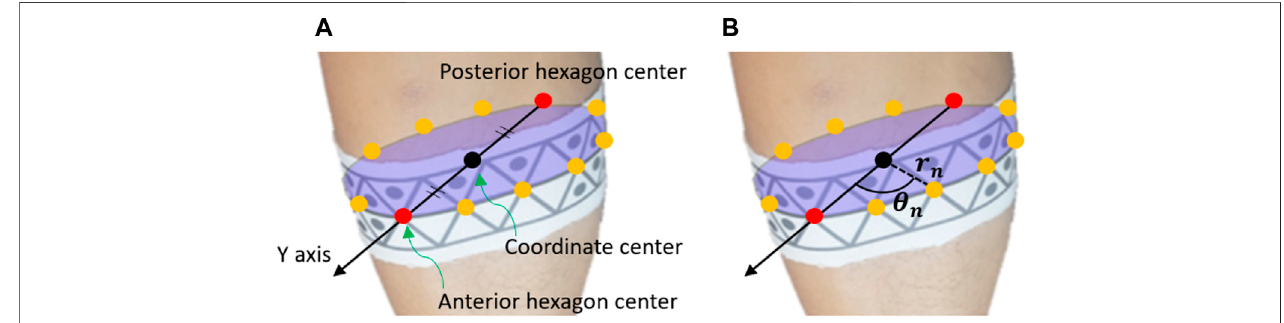
ROI that is centered at the vertex and has the same side length as the corresponding triangle is de fi ned for each triangle vertex. When the ROI contains six vertices, the binary code for the hexagon is scanned clockwise, beginning with the triangle associated with the ROI center ( Figure 4B ). This binary code is then utilized to identify the individual hexagonal pattern and, consequently, the comprising triangles. Lastly, in Step 5, the overlapping triangles of the neighboring hexagons are identi fi ed, and the fi nal pattern ID is determined ( Figure 4C ). When two or more cameras output the same ID, the 3D locations of the vertices of the pattern can be determined by triangulation.